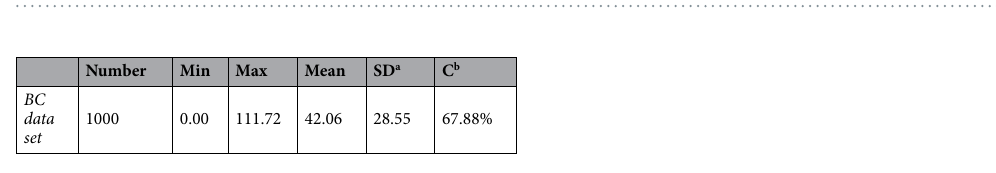
Figure 2. ( a ) BC incidence data histogram and ( b ) BC incidence data histogram after the data have been transformed as + BC log( 1) .